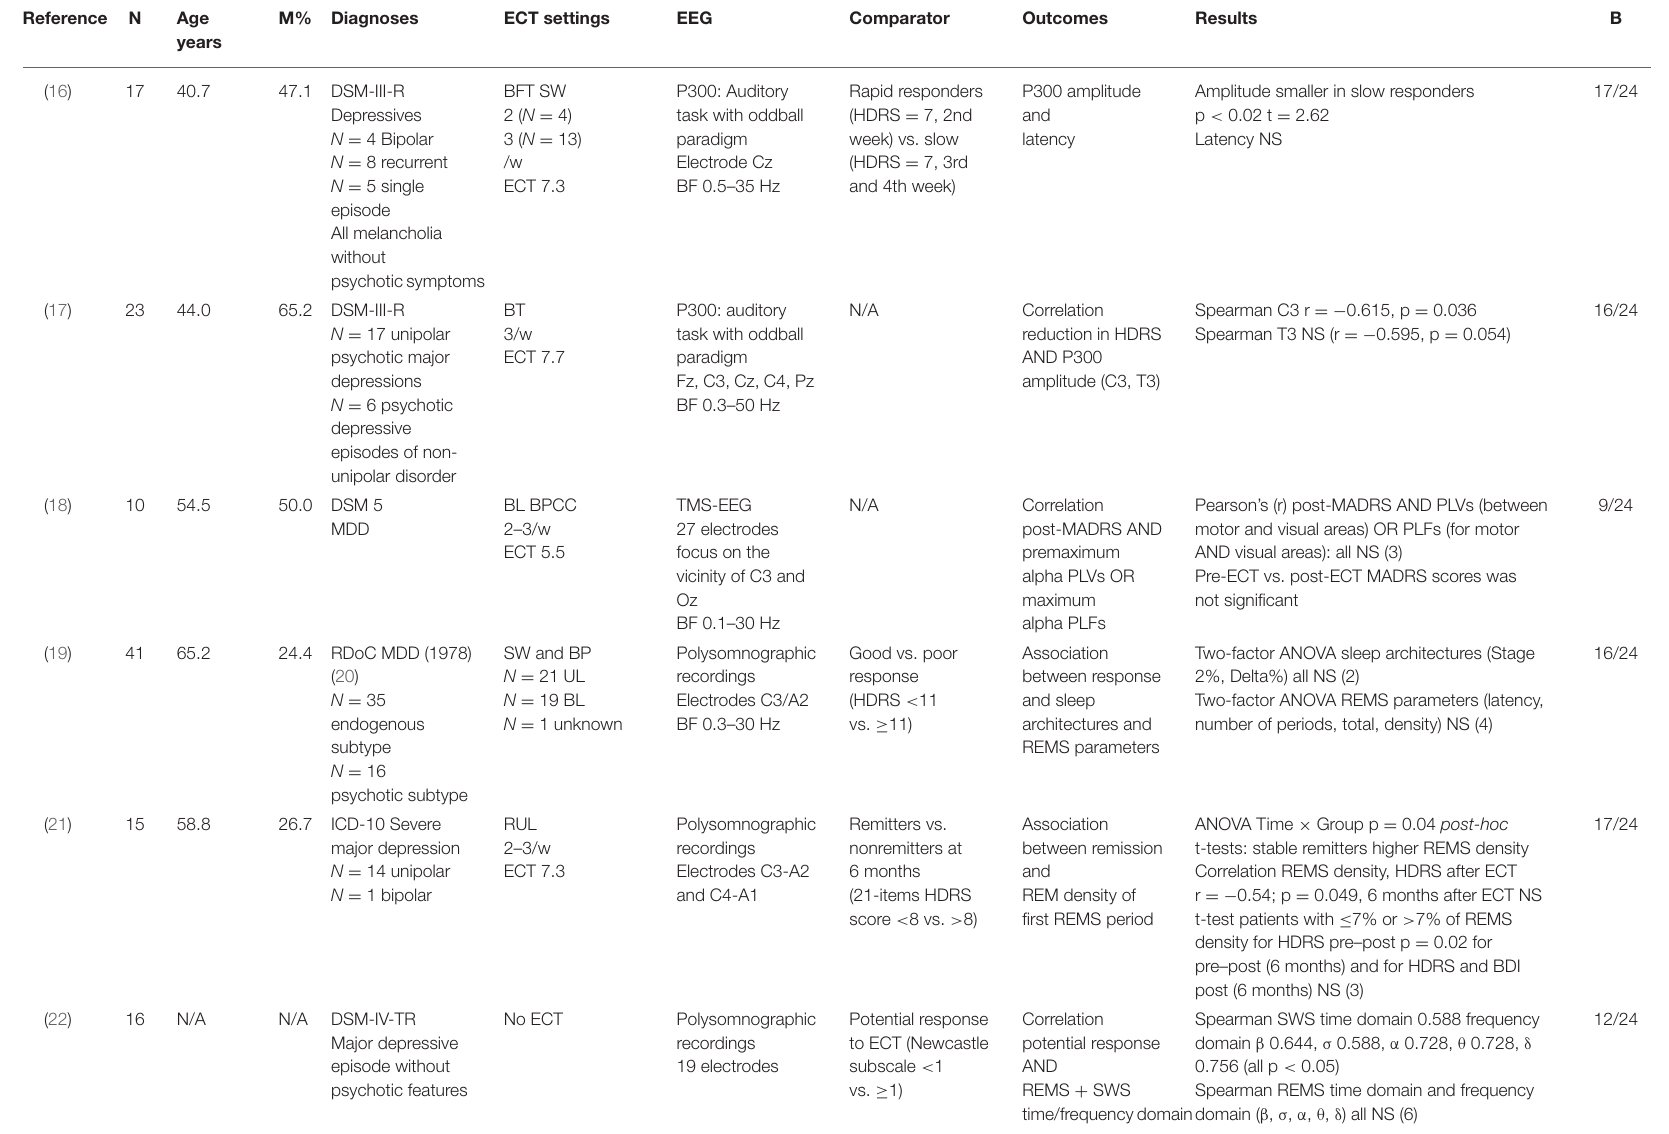
TABLE 1 | Study characteristics, results, and risk of bias within studies. Reference